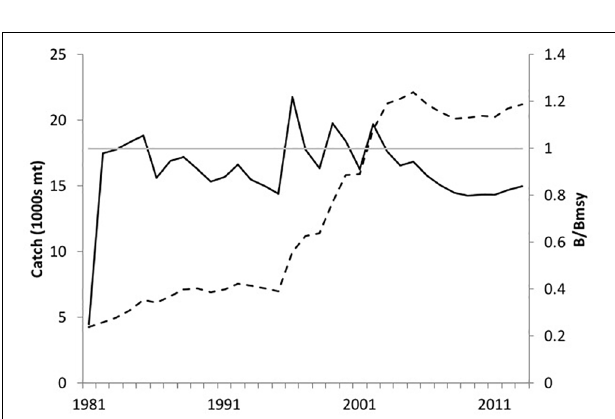
FIGURE 4 | Sustainability classification of commercially important fish groups caught in Somali waters.